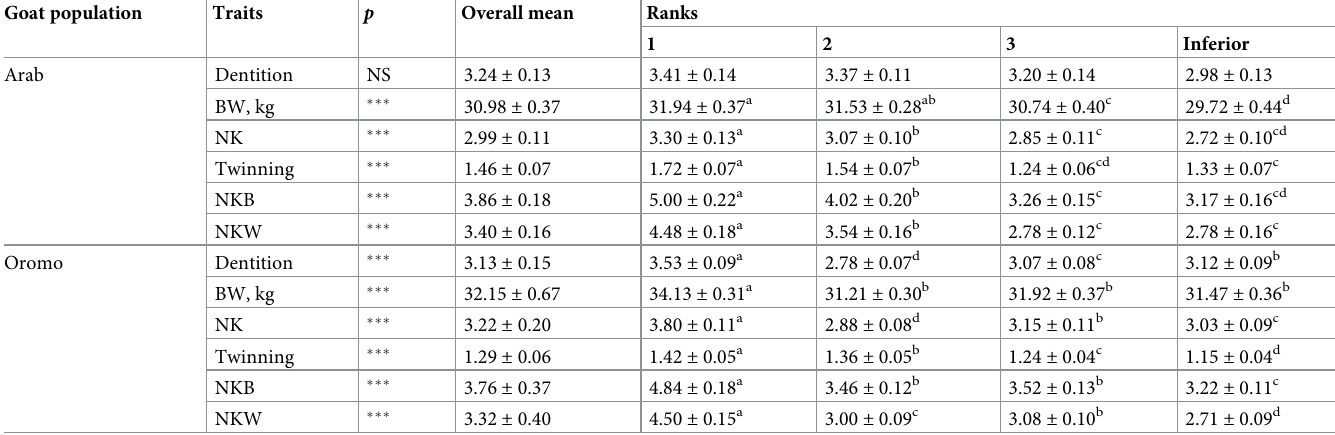
Row means within each goat population with different superscript letter are statistically different ��� p � 0.001; NS, non-significant; BW, body weight; NK, number of kidding; NKB, number of kids born/doe/kidding; and NKW, number of kids weaned/doe.